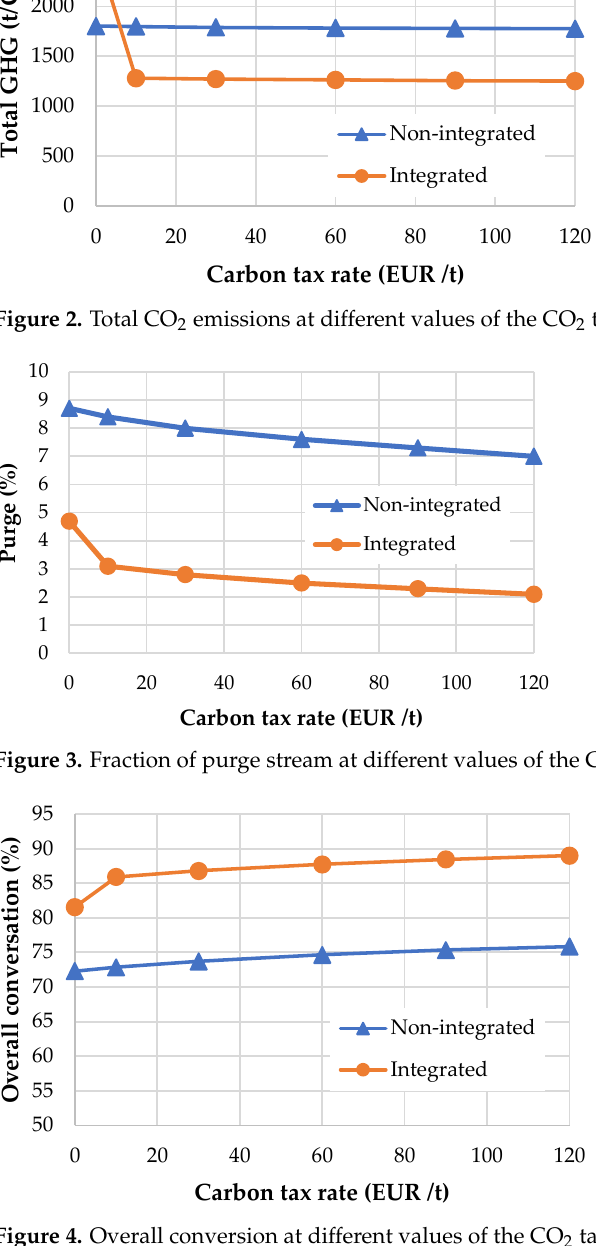
Figure 5. Raw material flow at different values of the CO 2 tax rate.